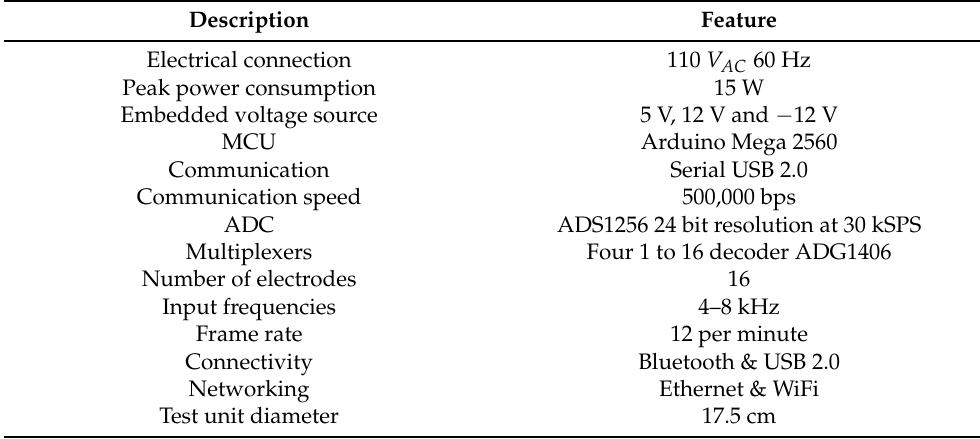
Table 1. Proposed EIT system features.